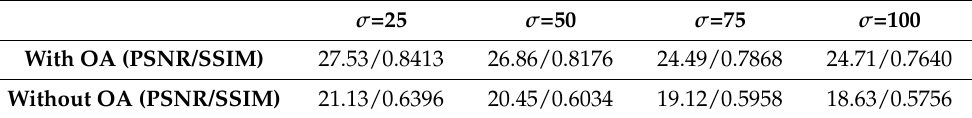
Table 3. Results of ablation experiments with no PGD (PSNR/SSIM). σ =25 σ =50 = = = = With OA